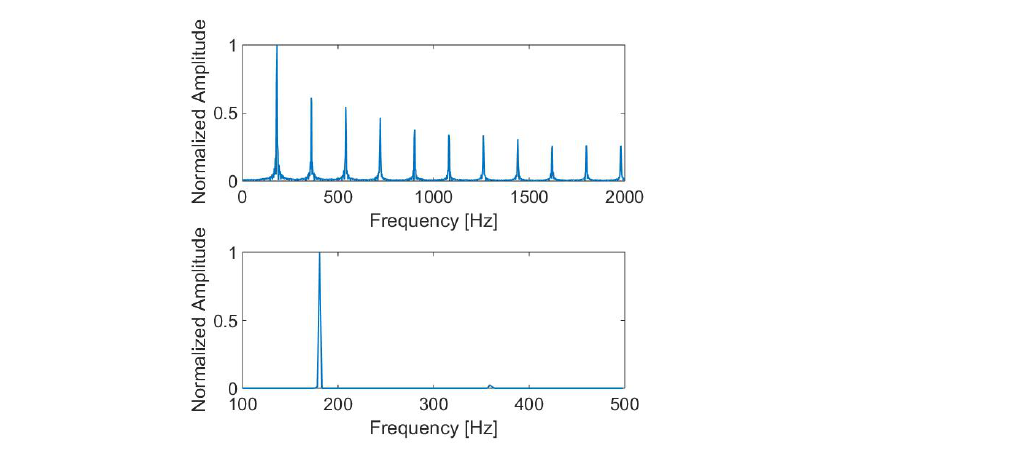
Figure 9. Magnitude of the Fourier transform of the simulated drone signal ( top ) and the SHC calculated with this spectrum ( bottom ).